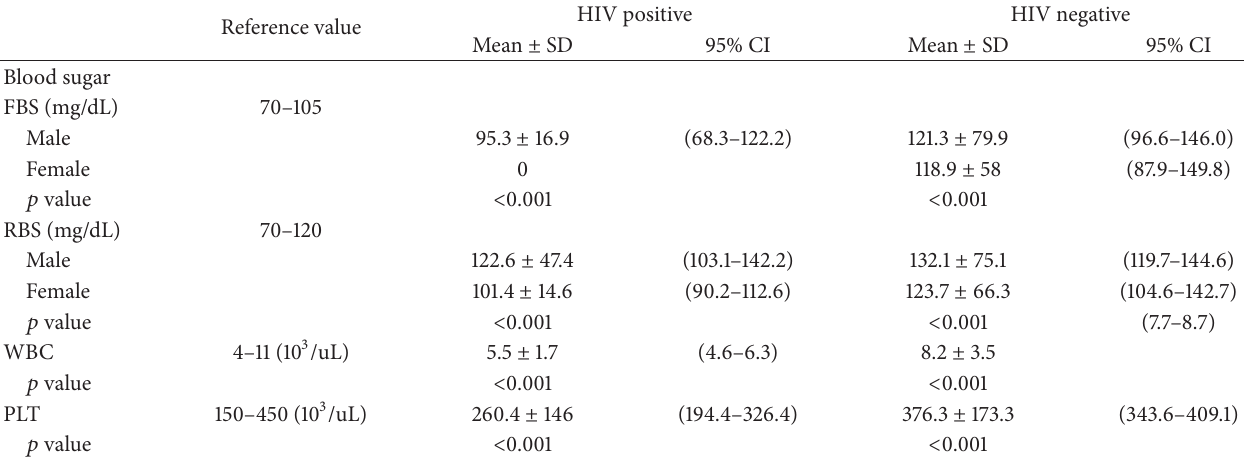
Table 3: Mean and SD of hematological parameters among TB and TB-HIV patients.